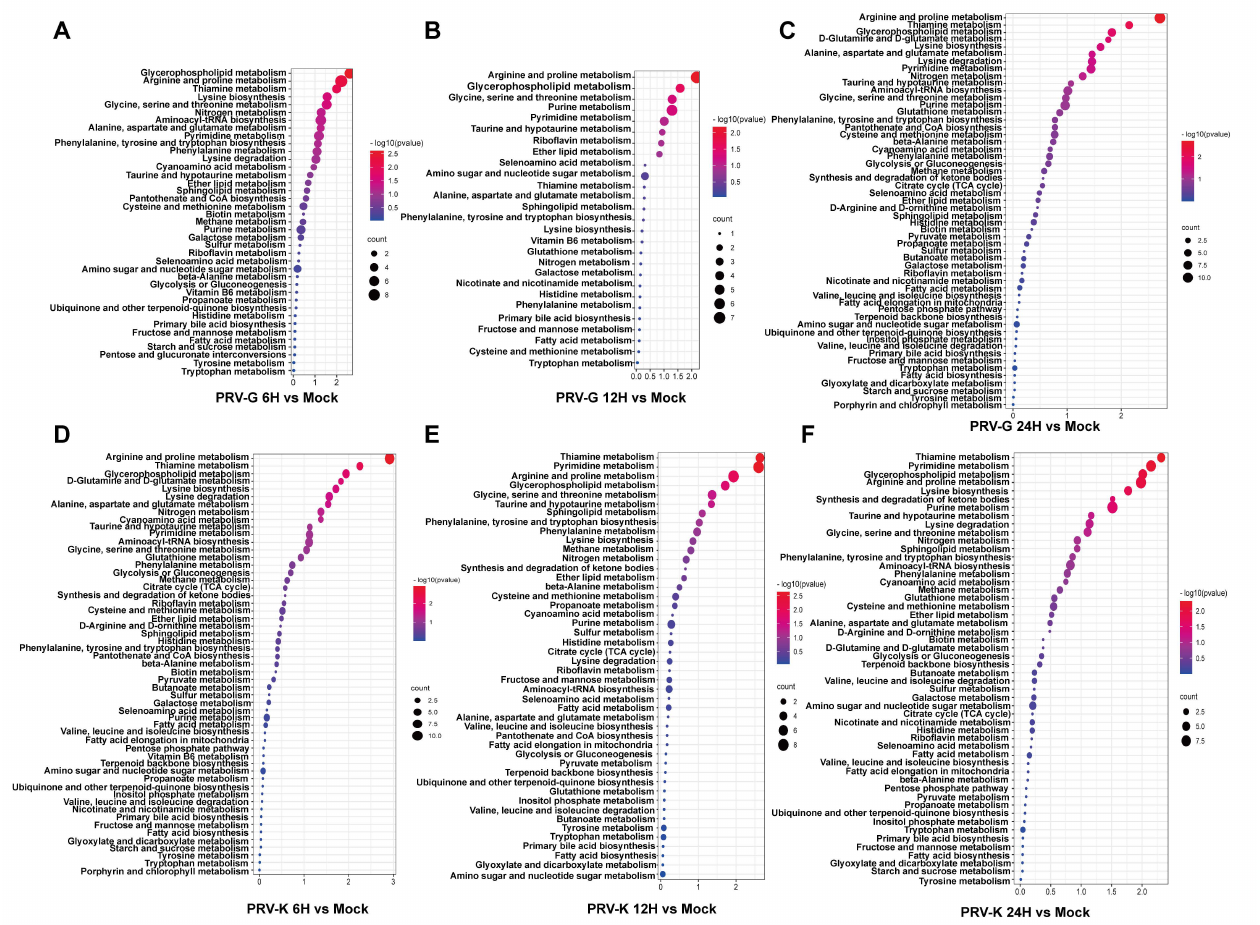
Figure 5. The KEGG-enrichment pathway analysis of differentially expressed metabolites for PK-15 cells infected with different PRV strains in different time courses. ( A – C ) PRV-G (6H, 12H, 24H); ( D – F ) PRV-K (6H, 12H,